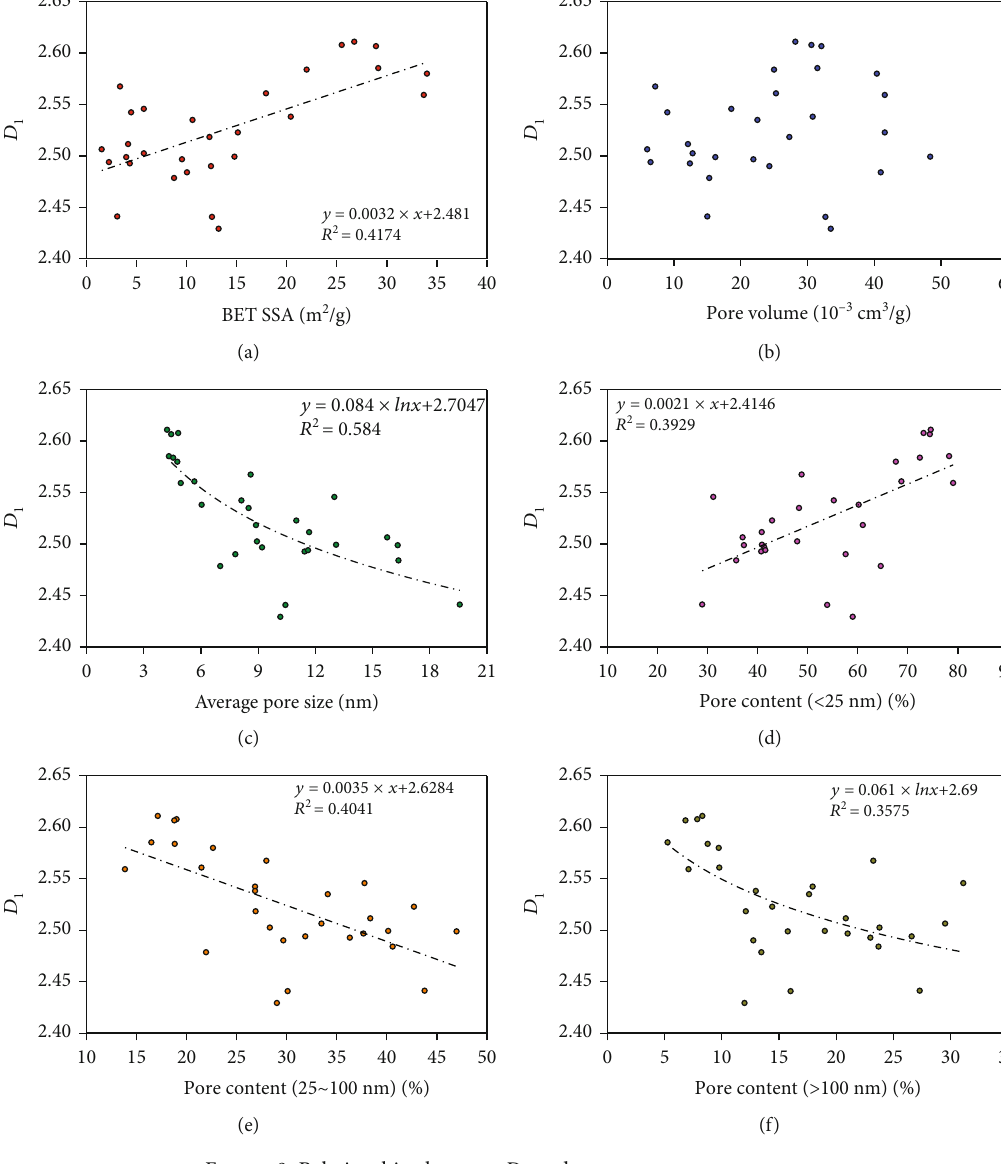
and pore structure 1